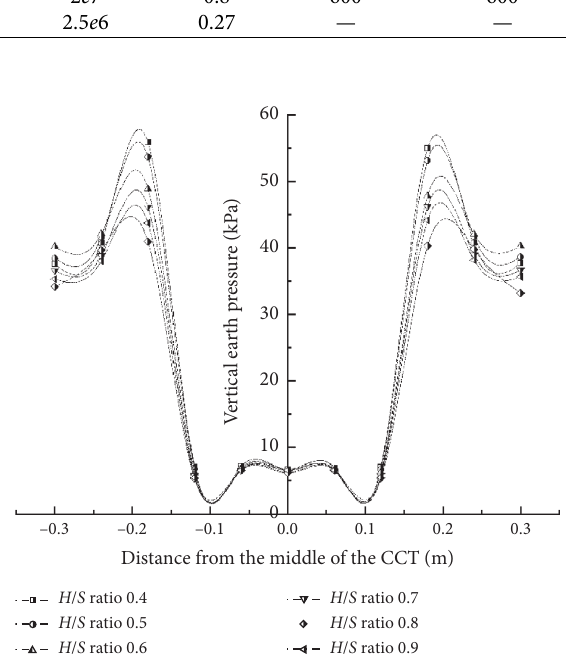
Figure 5: Variation of vertical eearth pressure for case S2 on top of